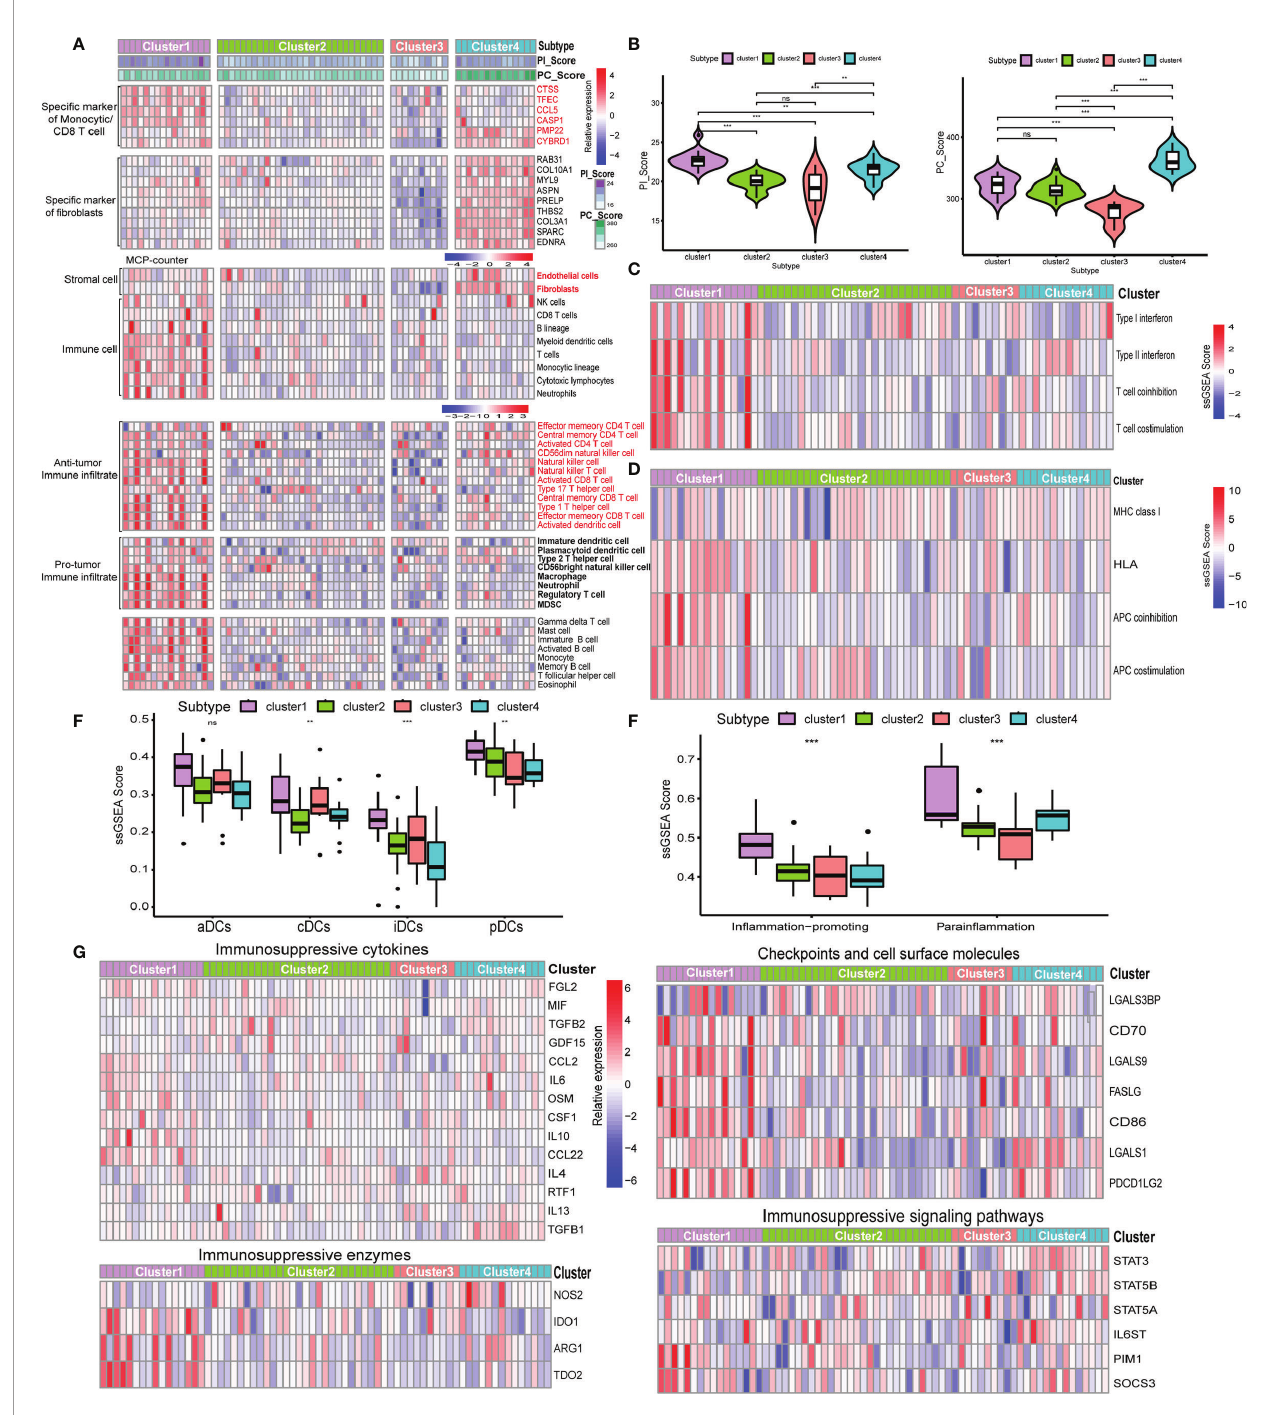
FIGURE 7 | Expression ofthe fi ve-pathway-related molecules was relatedto an effectiveimmune landscapein69 GEP-NENs liver metastases. (A) Heatmap of ssGSEA scores of speci fi c antitumorimmune cellpopulationsusing the same cell-related signatures. (B) The comparison of PI_Score and PC_Score amongthe foursubtypes inliver metastases. (C) Heatmap of median ssGSEA scores ofspeci fi c antitumor immune responses related to T-cellactivation among the foursubtypes. (D) Heatmap ofmedian ssGSEA scores of gene signatures upregulated in speci fi c antitumor immune responses relatedto APC activation amongthe four subtypes. (E) Box of median ssGSEA scores of DCincludingcDCs, iDCs, pDCs, and aDCs amongthe foursubtypes. (F) ssGSEA scores of two in fl ammation signatures (parain fl ammation andin fl ammation promoting)among the foursubtypes. (G) The comparisonofimmunosuppressive cytokines, enzymes, signalingpathways, checkpoints, and cellsurfacemolecules among the foursubtypes. P values <0.05 were consideredsigni fi cant (ns, P > 0.05; *,P < 0.05; **,P < 0.005; ***, P <